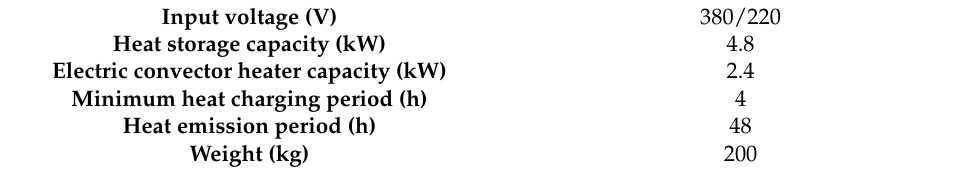
Figure 2. Electric thermal storage unit. Table 1. Technical characteristics of ETS unit.